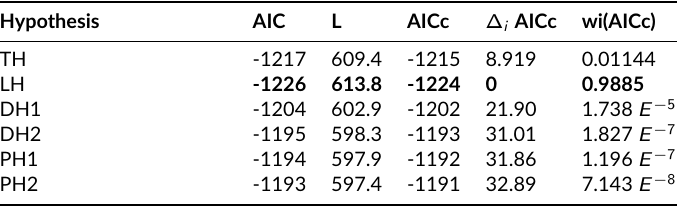
Table 5 – Support (AIC and AICc weights) for the six topologies, reflecting the six hy- potheses about the origin of extant amphibians, under the speciational model (called Pure-Phylogenetic / Equal in Tables 2–4), with dataset 1 (see Table 1). Dataset 1 includes six cranial characters (nasal, parietal, squamosal, maxilla, pterygoid, and exoccipital) and 107 taxa (including, among Paleozoic taxa, Apateon and Sclerocephalus ). Abbreviations and boldface as in Table 2, except ∆ i : difference of AICc from that of the LH. Hypotheses from top to bottom: TH: monophyletic origin among temnospondyls; LH: